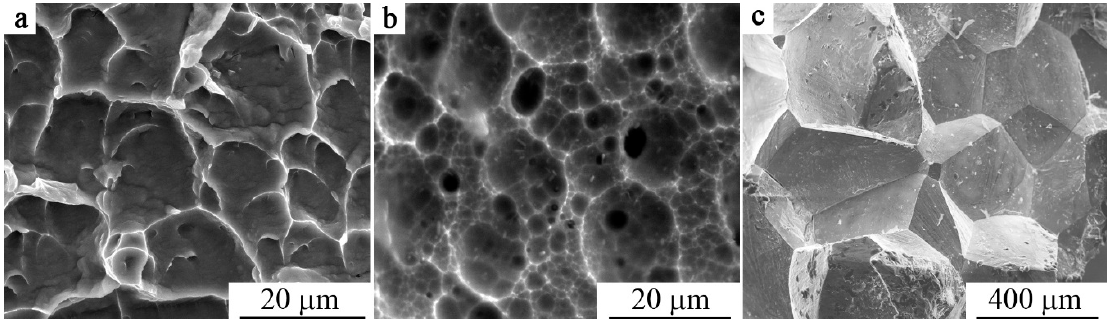
Figure 15. Fractography of ( a , b ) alloy Ti 49,4 Ni 50.6 ( a ): After quenching, ( b ): HPT five turns at 6 GPa and subsequent annealing at 823 K and ( c ) quenched alloy Cu 69 Al 28 Ni 3 .